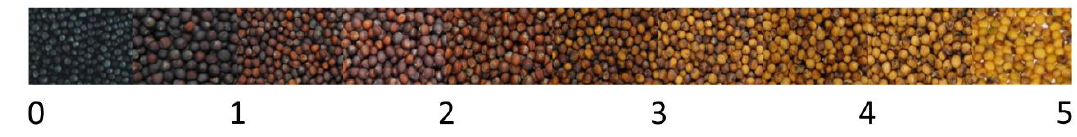
Figure 1. Seed colour on a scale from 0 (black) to 5 (yellow).